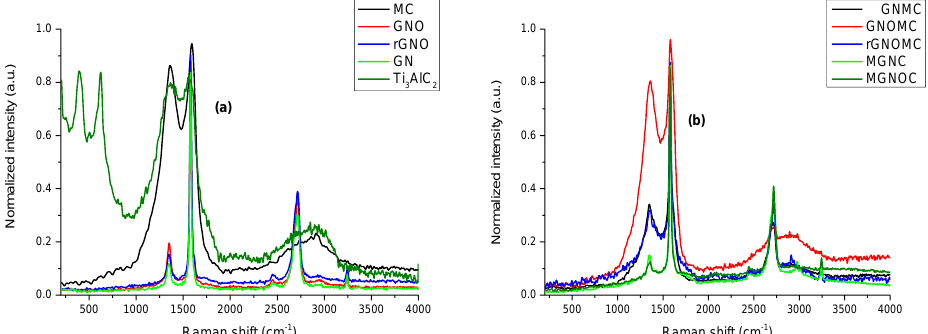
Figure 2. Normalized Raman spectra of ( a ) MXene, MC, GN, GNO, rGNO, and ( b ) composites.